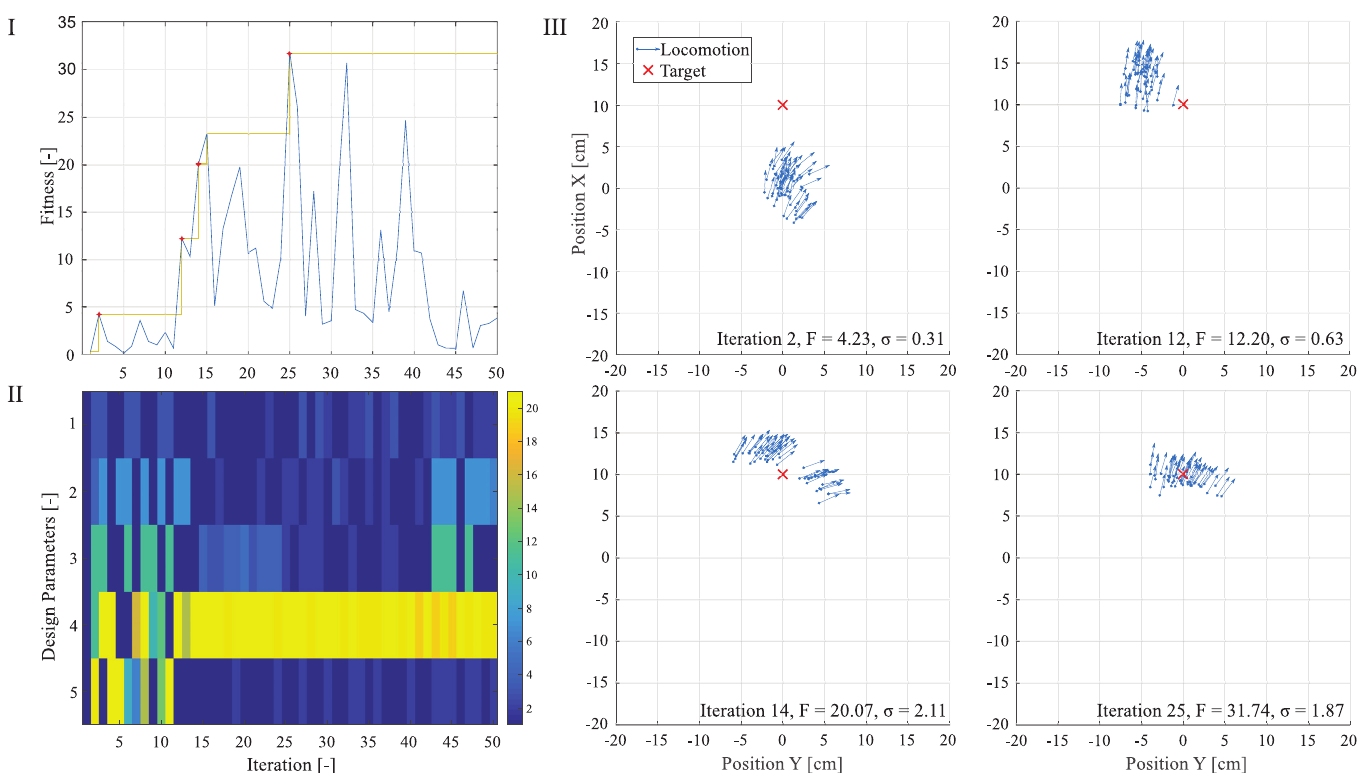
Fig 2. Morphology and control co-optimization. (I) The initial results of our MC co-optimization shows that the system graduallyimproves its performance until an optimum is reached. (II) The interplaybetweendesign parameters shows a highly exploratoryinitial behavior until iteration 12, followedby exploitative measuresto discover the globaloptimum, and later returningto exploration to assure that the optimum is not local. (III) The trajectories for iterations2, 12, 14 and 25 are highlighted with the end position and rotation of each trial, and their proximity to the target defines their fitness